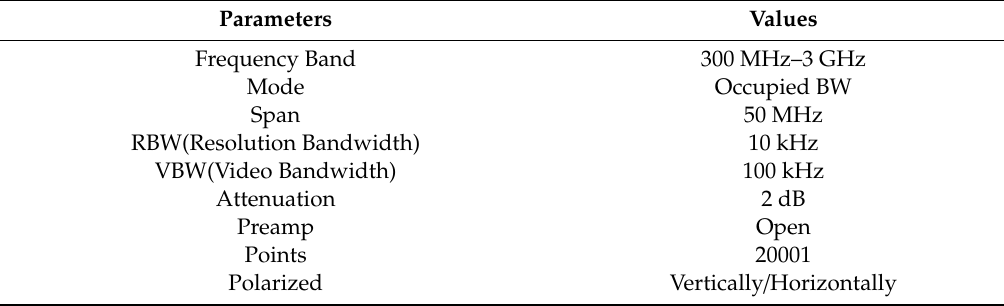
Table 1. Parameters of frequency domain measurements.